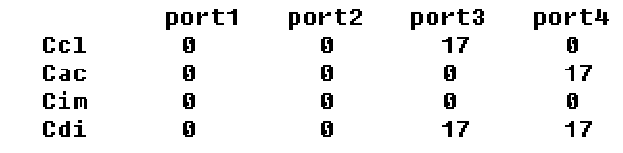
Fig. 11. The simulation result of node